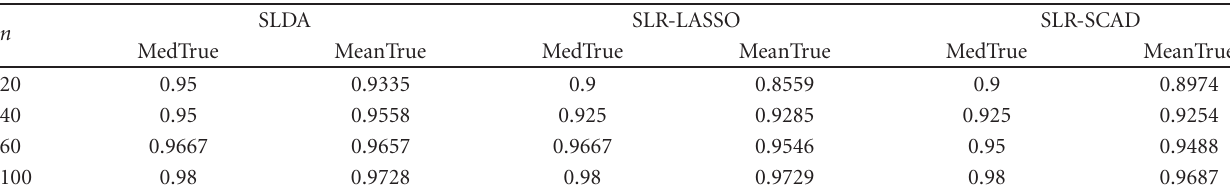
Table 1: True classification ratio simulations results.